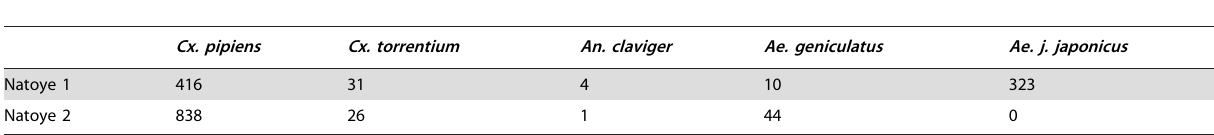
Table 3. Total number of larvae of each species caught in Natoye 1 (71 larval habitats) and Natoye 2 (65 larval habitats).